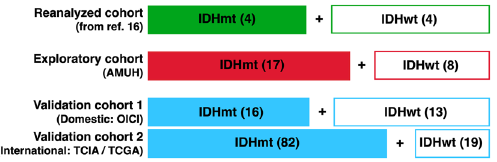
Figure 1. Overall study cohort. First the correlation of rT1/T2 with T1- and T2-relaxation time was investigated by reanalyzing the raw data from ref. 16 . Then, the study was conducted in two stages, as